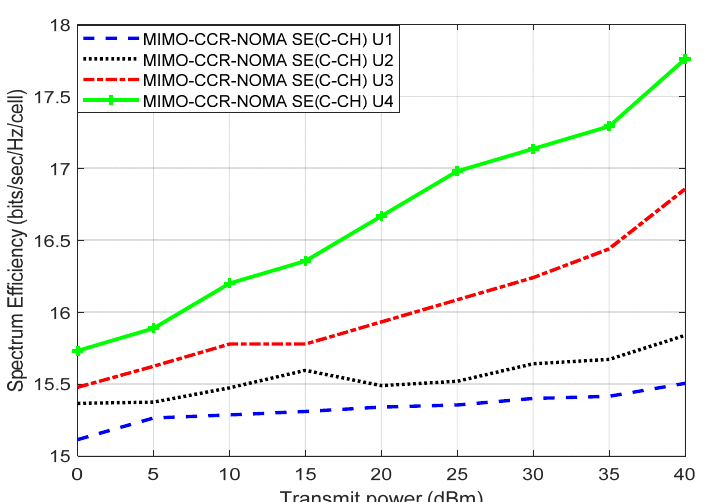
Figure 8. SE against transmitting power for 4 users’ 64 × 64 MIMO DL-NOMA PD with C-CH CCRN.